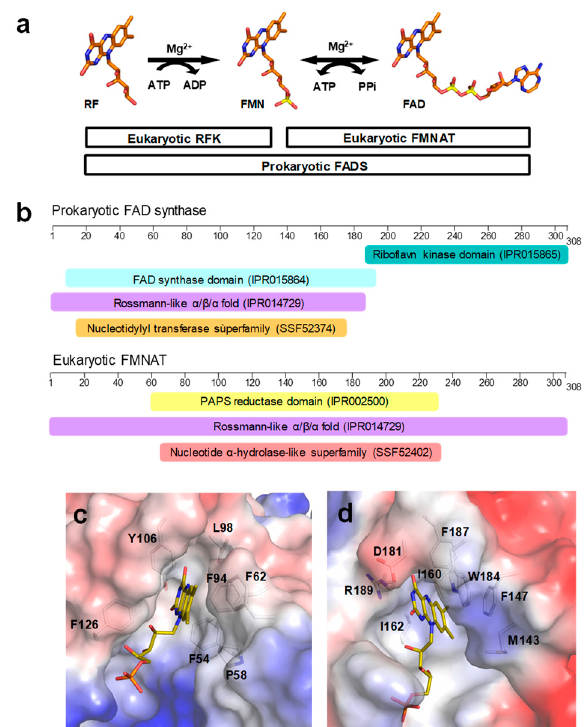
Figure 1. Sequence and structural features in FADSs. ( a ) Scheme of the flavin mononucleotide (FMN) and flavin adenine dinucleotide (FAD) biosynthetic pathway from riboflavin (RF) in eukaryotes and prokaryotes. ( b ) Classification of family domains for Ca FADS and Cg FMNAT as predicted by InterPro (https://www.ebi.ac.uk/interpro/). Electrostatic surface of the flavin mononucleotide adenylyltransferase (FMNAT) active site in ( c ) the FMNAT module of Ca FADS (PDB 2x0k) with flavin mononucleotide (FMN) docked according to Reference [12] and in ( d ) Cg FMNAT (PDB 3g5a) with FMN. Residues interacting with the ring are shown in sticks.